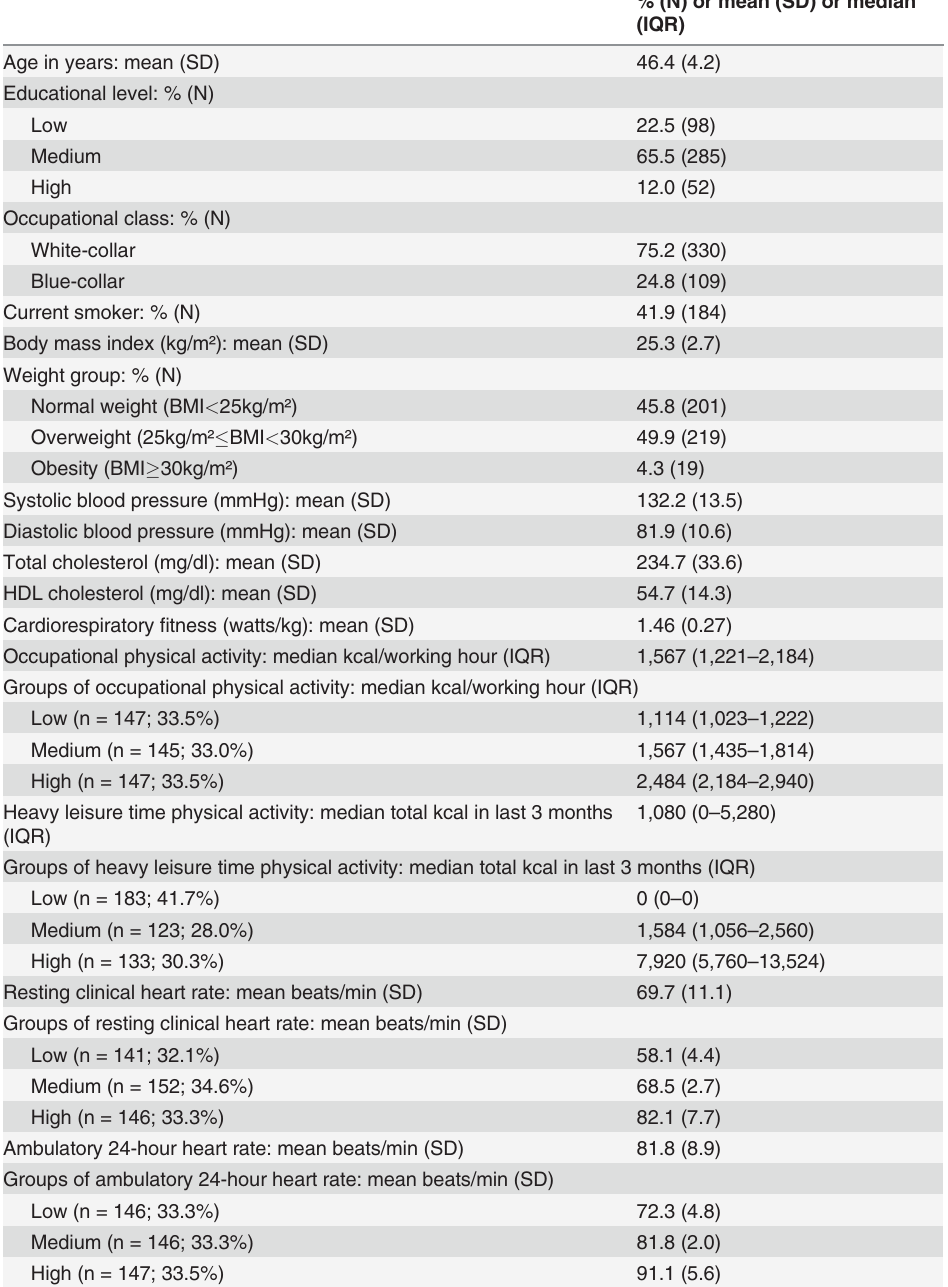
Table 1. Description of baseline characteristics in 439